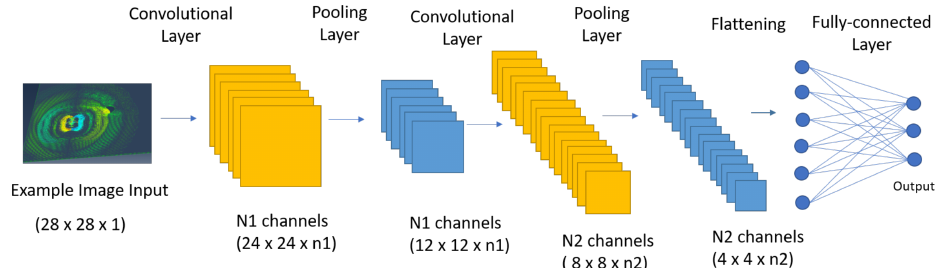
Figure 5. Architecture of a CNN comprising convolutional and pooling layers with a final flattening layer. The dimensions of each layer are represented under each